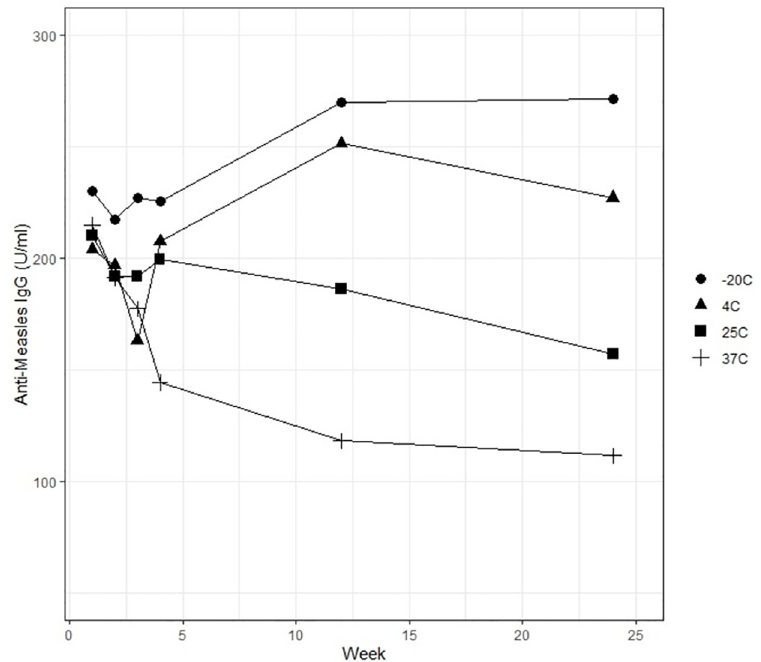
Fig 1. Stability of the blood samples on DBS cards stored under various temperatures for 25 weeks as measured by the titers of anti-measles antibody (IgG) at various time and temperature points.